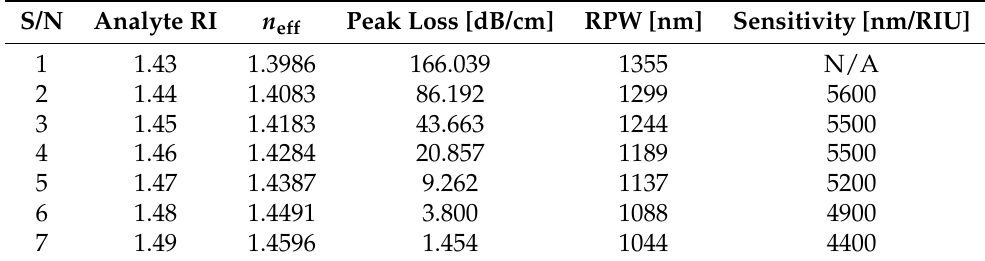
Figure 2. Confinement loss spectra of analyte with different RI n a in the range from 1.43 to 1.49. Table 1. Sensing performance of the HC-PCF-based SPR sensor in the RI range from 1.43 to